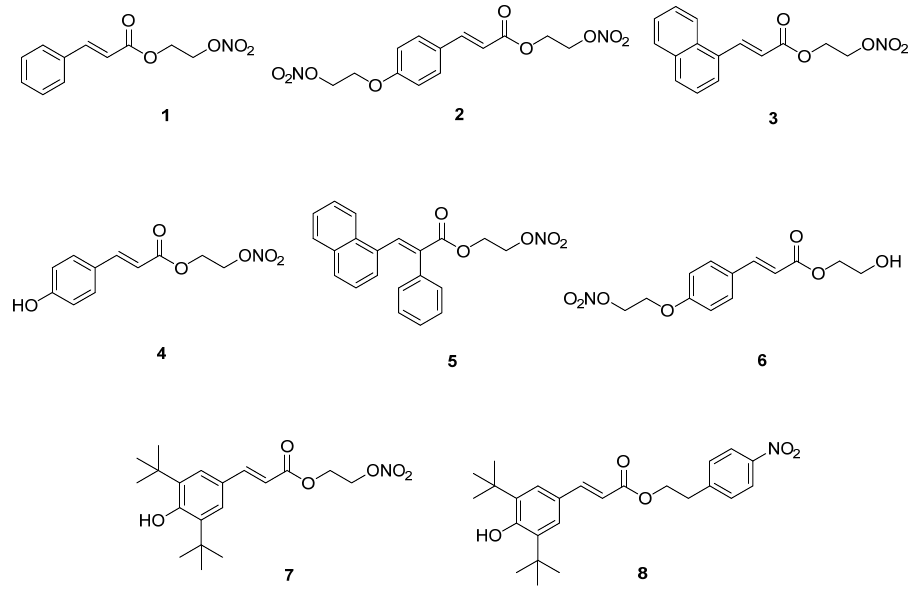
Figure 3. Chemical structure of the nitrooxy esters of cinnamic acids 1 – 8 with anti-inflammatory and antioxidant activities [33].